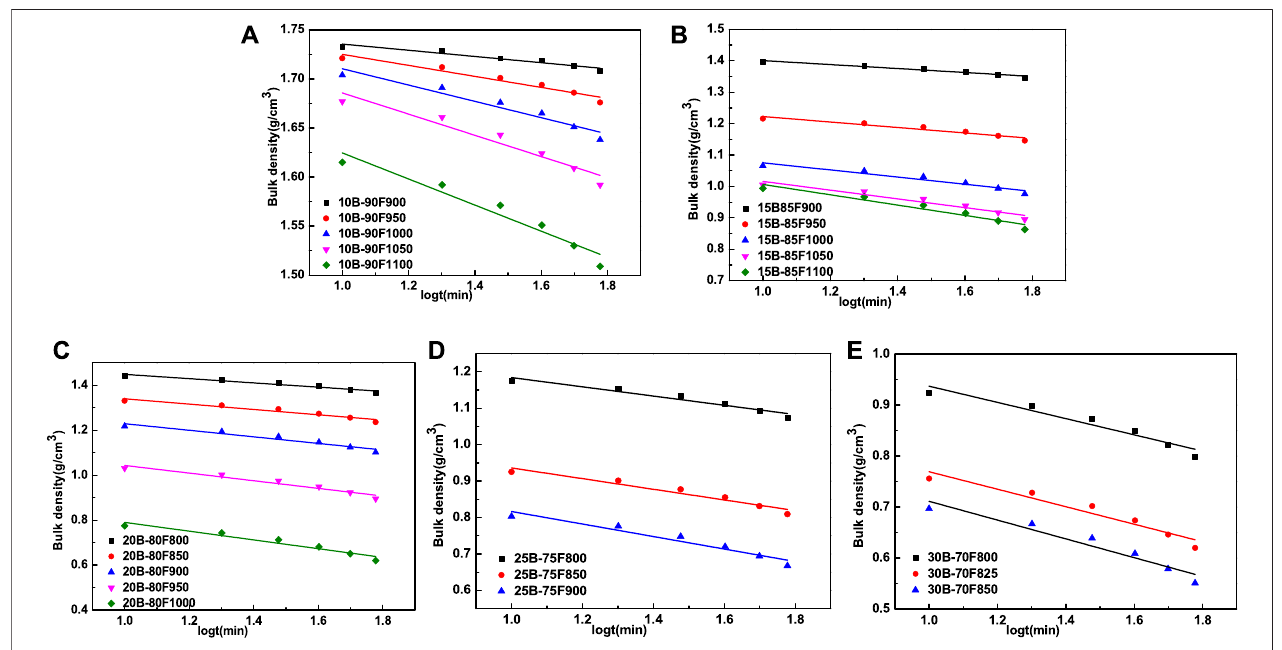
FIGURE 5 | Bulk density (D) vs. log t graph for samples with different borax additions.